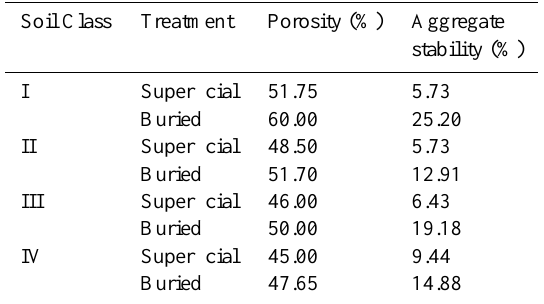
Table 3. Soil physical properties after the